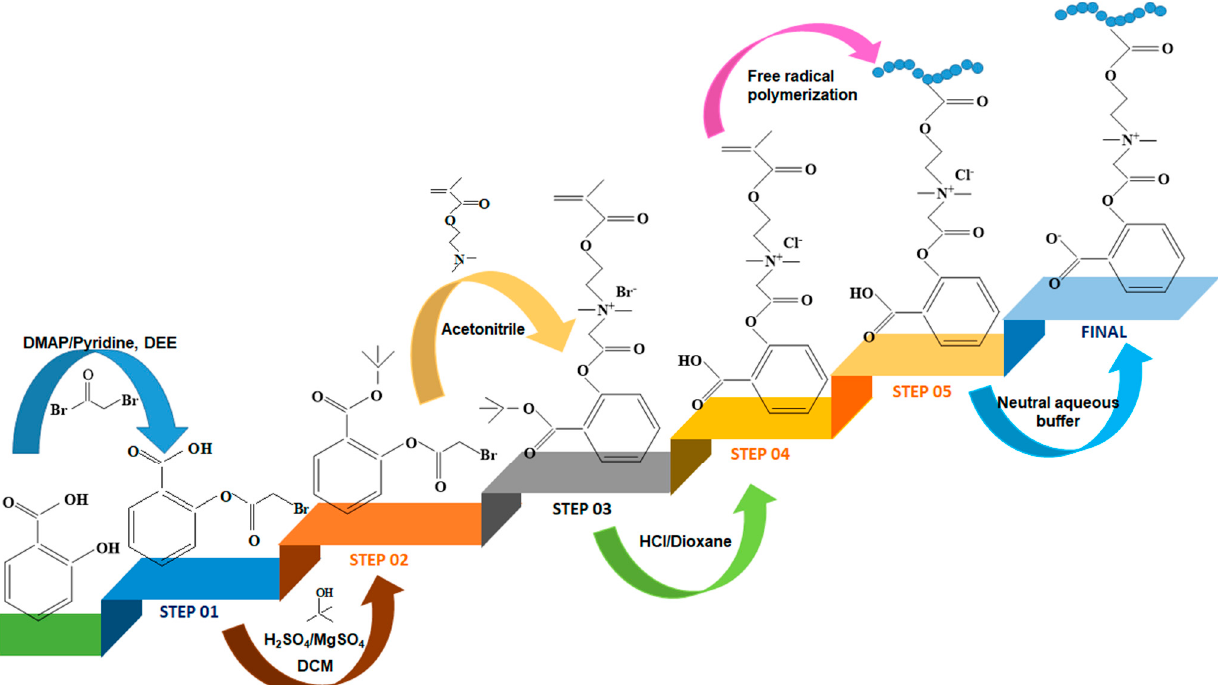
Figure 4. Schematic representation for the synthesis of PCBSA polymer (adapted from Ref. [85]) DMAP—4-(dimethylamino) pyridine; DEE—anhydrous diethyl ether; DCM—dichloromethane).